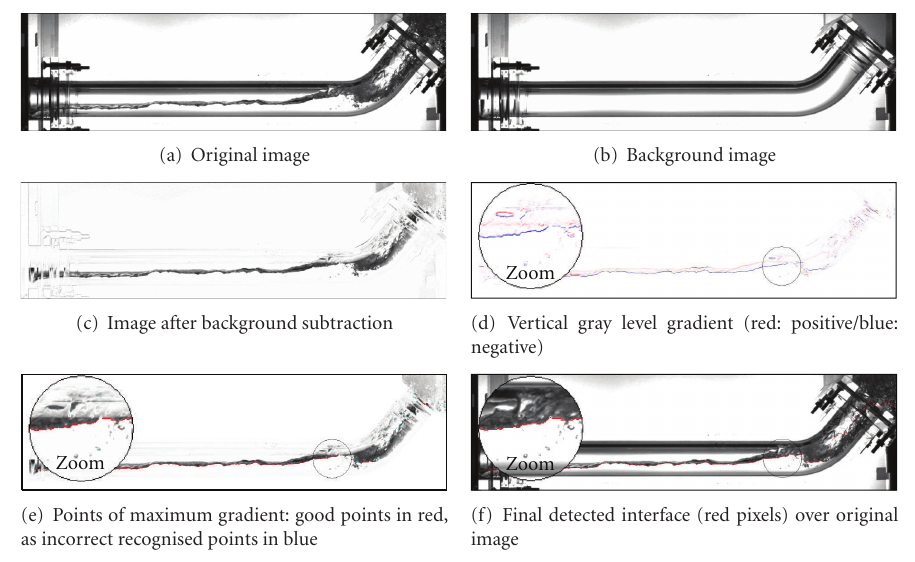
Figure 5: Visualisation of the main steps of the image processing (image taken during CCFL at j L ,in = 0.25 m/s and j G = 4.0